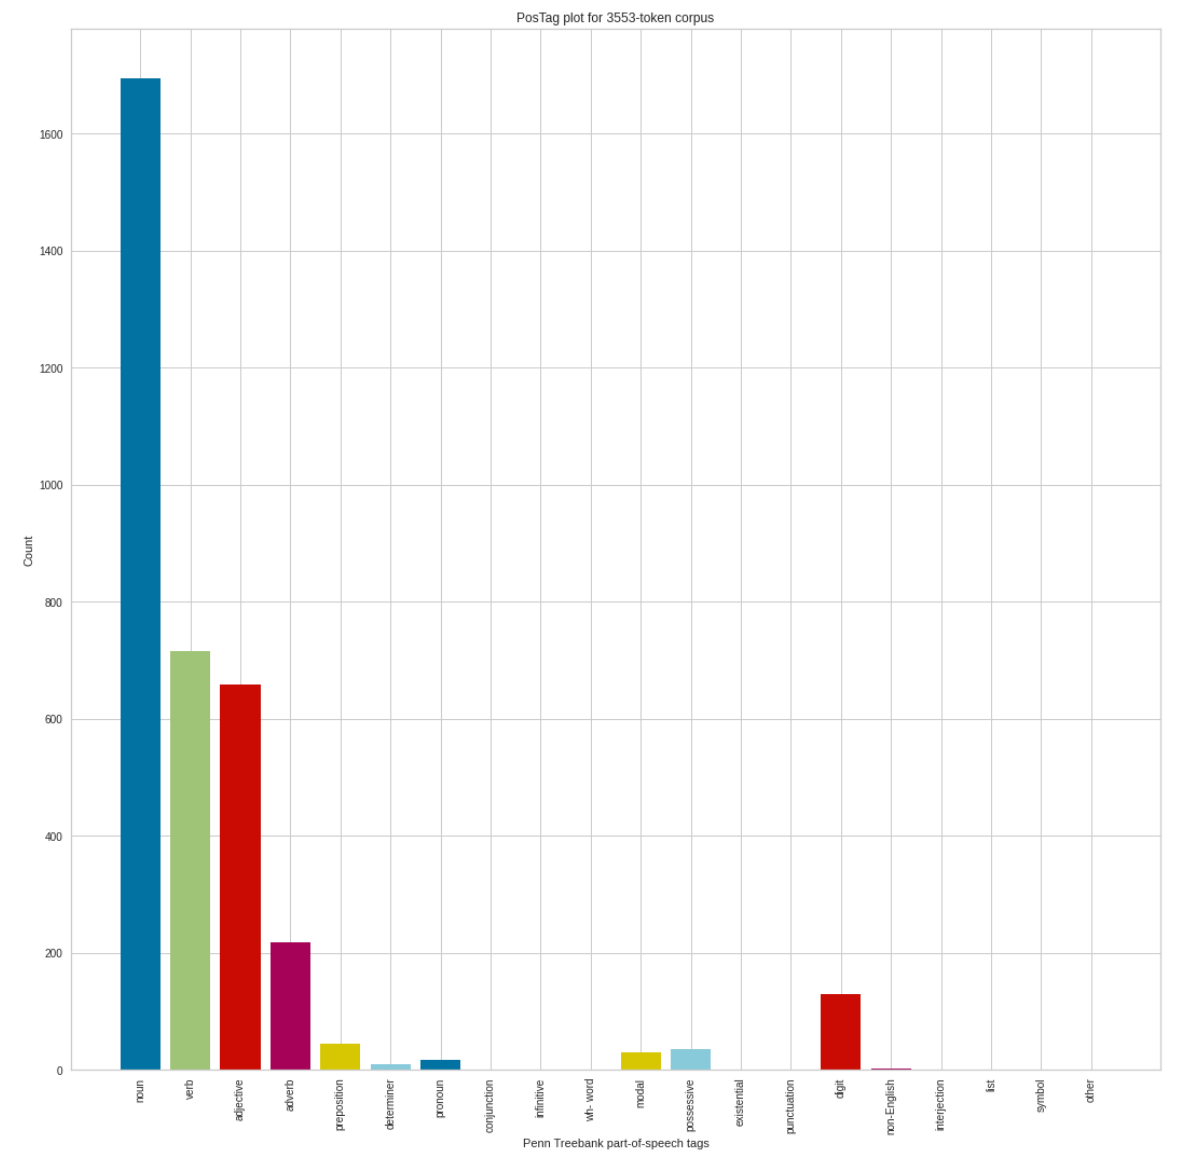
Figure 11. Part of speech tagging for positive tweets. The time period stands between 29 August 2021 and 31 August 2021. Following the POS analyses, let’s look at the results of the dependency graph (Figure 12 shows the structure of the tweet), using the positive twitter post with the most followers from the August dataset. There are two links at the end of the tweet; this is covered in the figure.